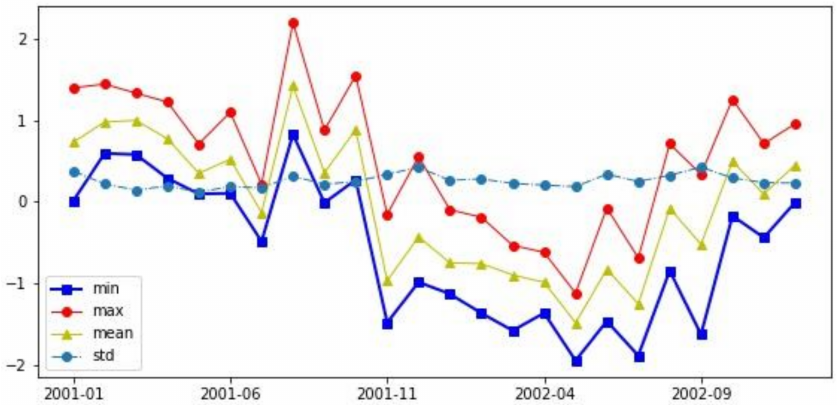
Figure 6. Zonal statistical calculations for Zone